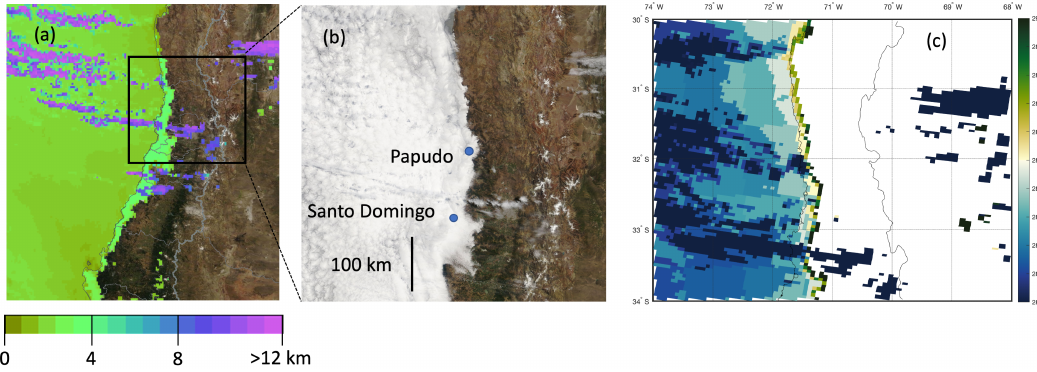
Figure 9. ( a ) MODIS terra cloud height on 20 Jan 2019 3:00 p.m. UTC, ( b ) MODIS True Color (Terra, Day) 20 January 2019 3:00 p.m. UTC, and ( c ) MODIS Cloud Top Temperature [K] (Terra, Day) 20 January 2019 3:00 p.m. UTC.